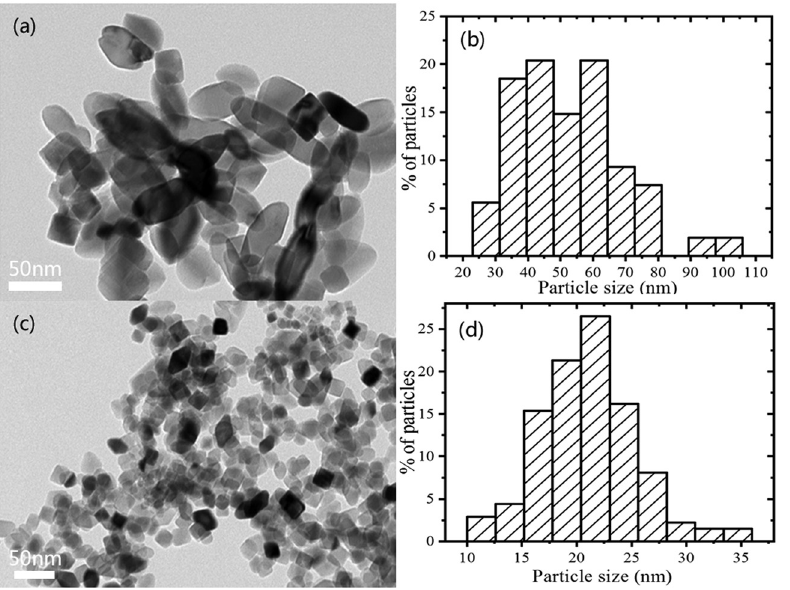
Figure 5: TEM photographs and size distributions of products collected from TiCl 4 at 400°C and 30 MPa, ( a ) and ( b ) [ OH ] − /Ti 4 + = 4, ( c ) and ( d ) [ OH ] − /Ti 4 + =